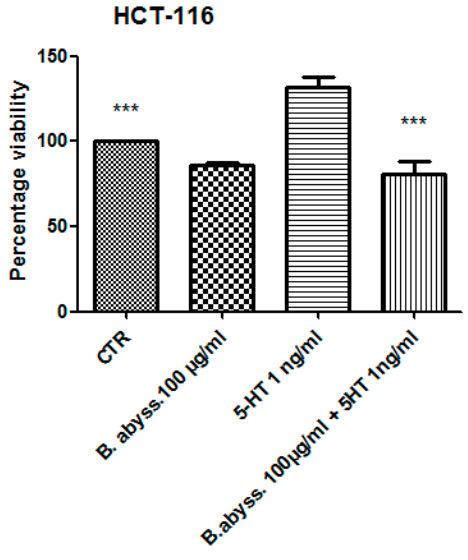
Figure 2. Effects of B. abyssinica water extract 100 μ g/mL basal and serotonin (5-HT)-induced on colon cancer HCT116 cell viability (MTT test). Data are means ± SD and analyzed through analysis of variance (ANOVA), followed by post hoc Newman–Keuls test. ANOVA, p < 0.0001; post hoc , *** p < 0.001 vs. 5-HT (serotonin) group. The B. abyss. 100 μ g/mL group reported in the picture was compared with the sole CTR group ( p > 0.05).